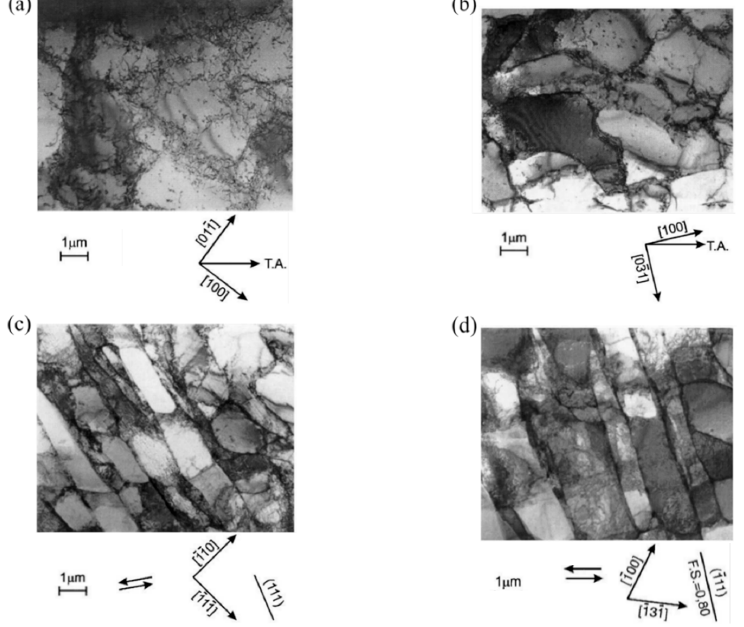
Figure 10. The TEM observations of dislocation tangles after tensile deformation along the [011] orientation when deformed by a strain of ( a ) 0.06 and ( b ) 0.12 and the TEM observations after simple shear deformation at 0.3 shear strain for ( c ) 45° and ( d ) 90° shear [97].